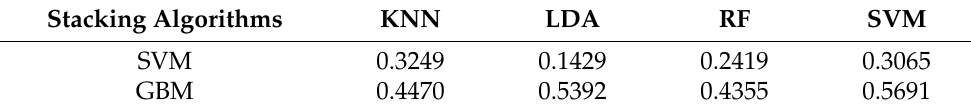
Table 5. Accuracy values of stacking algorithms for the stairs